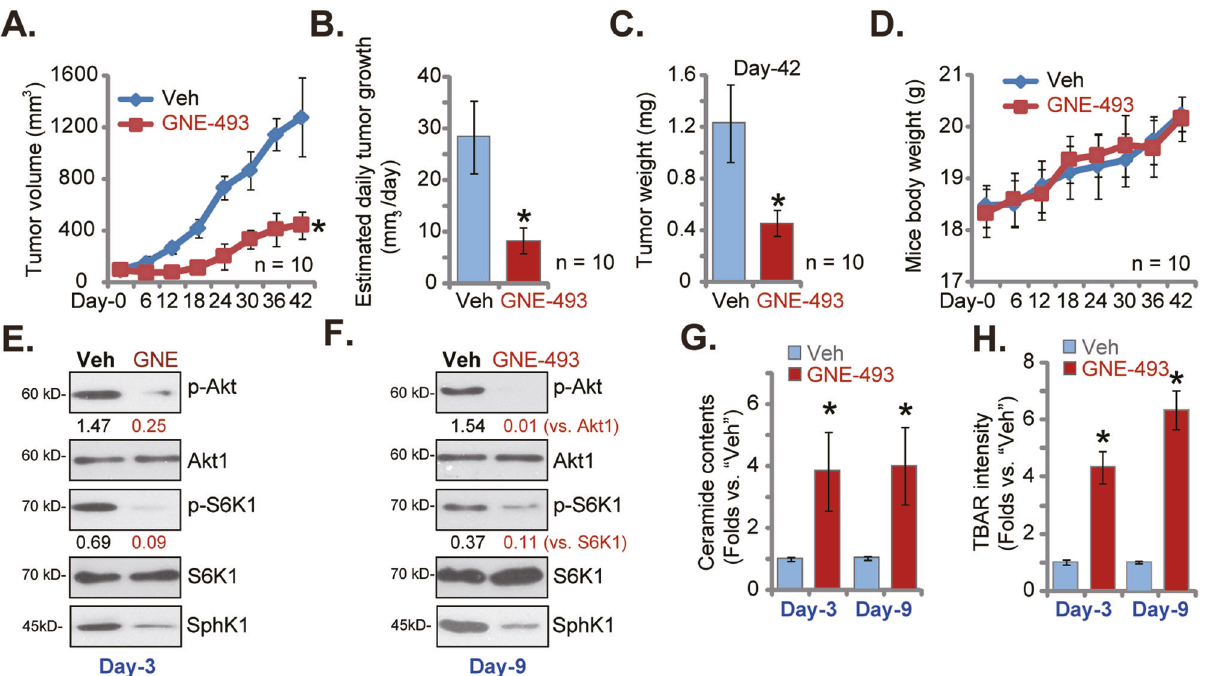
Fig. 6 GNE-493 oral administration inhibits prostate cancer xenograft growth in nude mice. The priCa-1 xenograft tumor-bearing nude mice were subject to daily oral administration of a single dose of GNE-493 (20 mg/kg body weights, 12 days) or the vehicle control ( “ Veh ” ); volumes of xenograft tumors ( A ) and the animal body weights ( D ) were recorded; the estimated daily tumor growth was calculated as well ( B ); the xenografts were all carefully isolated and weighted at Day-42 ( C ). At experimental Day-3 and experimental Day-9, one tumor from each group was isolated 6 h after initial GNE-493 or vehicle administration. In the tumor tissues listed proteins were examined ( E and F ). Total ceramide contents ( G ) and the relative TBAR activity ( H ) were examined as well. * P < 0.05 versus “ Veh ”